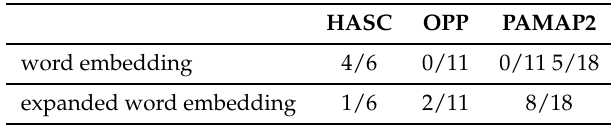
Table 9. Degree of similarity between the embedding space and the attribute vector space, i.e., the ratio of matching words in the nearest classes for each class in Figures 4, A1 and